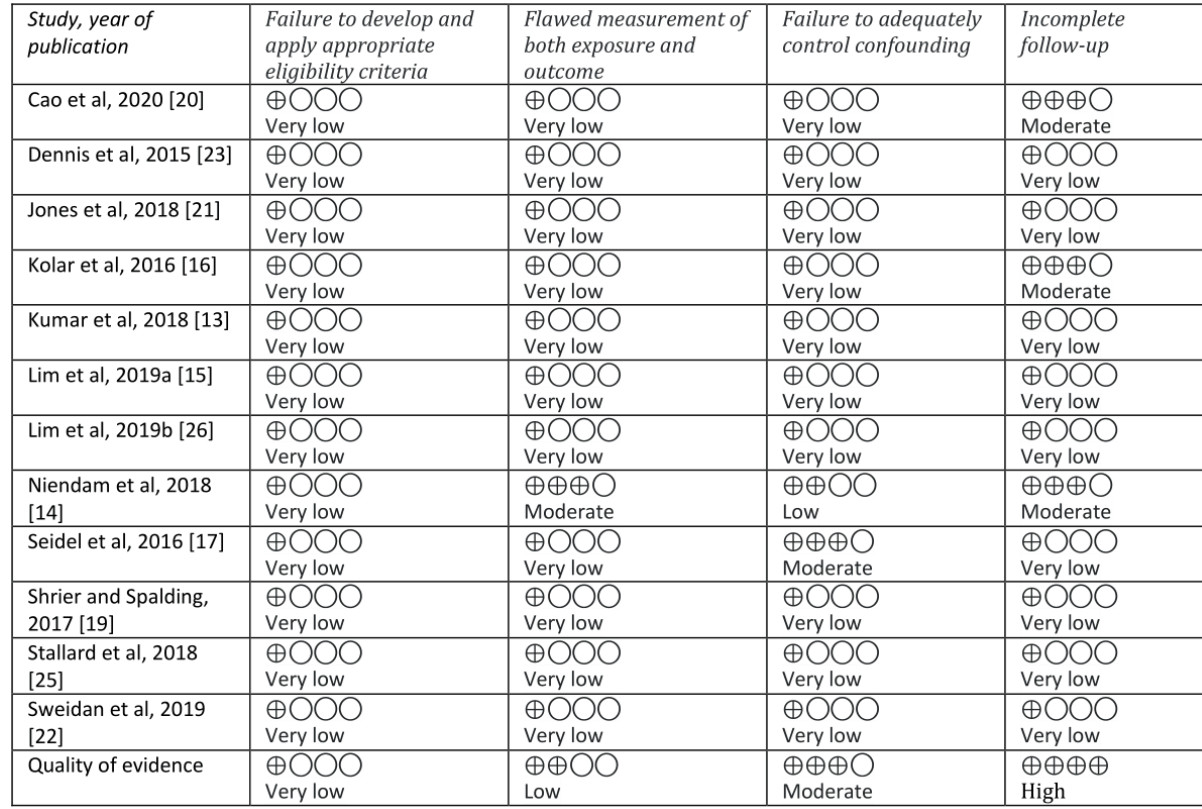
Figure 3. Grading of Recommendations, Assessment, Development and Evaluations (GRADE) quality of evidence chart for nonrandomized